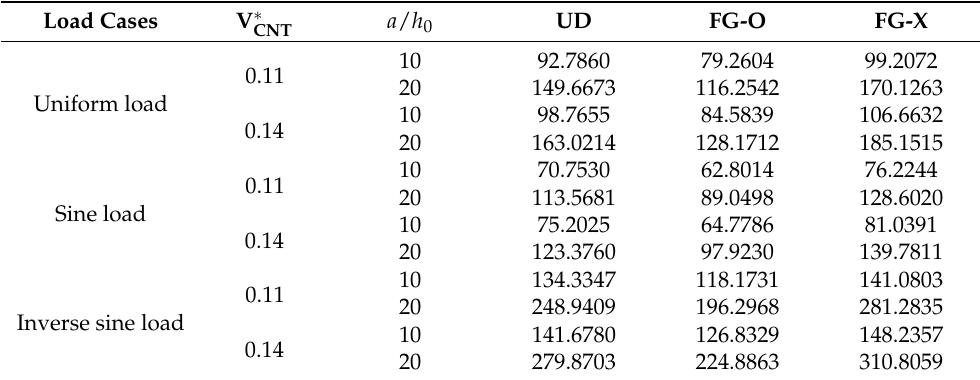
Table 5. The effects of the CNT distributions, CNT volume fractions, and length to thickness ratio on the variations of the dimensionless biaxial buckling load of the FG-CNTRC microplate under uniform and nonuniform edge loads (CCSS).